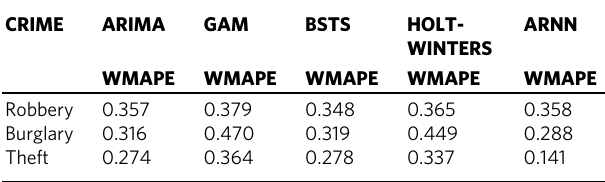
mean absolute percentage error.